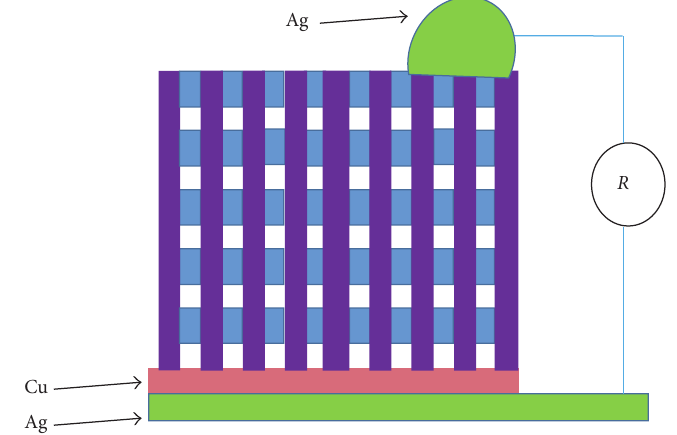
Figure 1: Schematic structure of the GMR measurements.